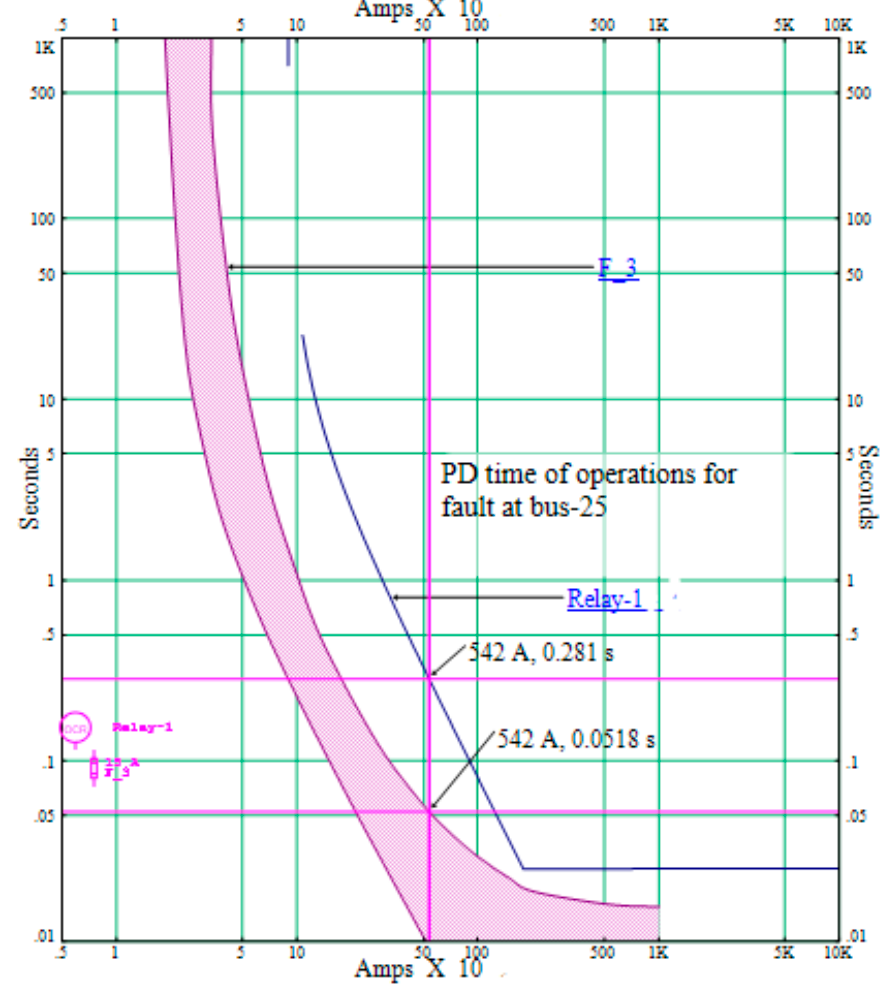
Figure 7. Log–log diagrams of the relay and downstream fuse 3.